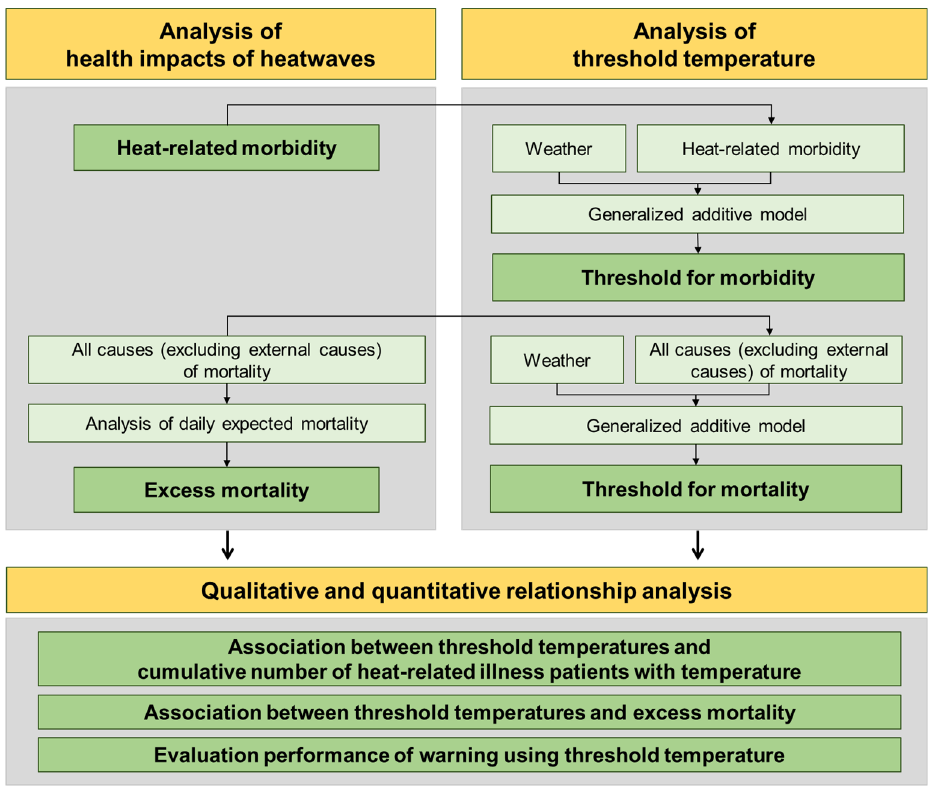
Figure 1. Flowchart of the study procedure.